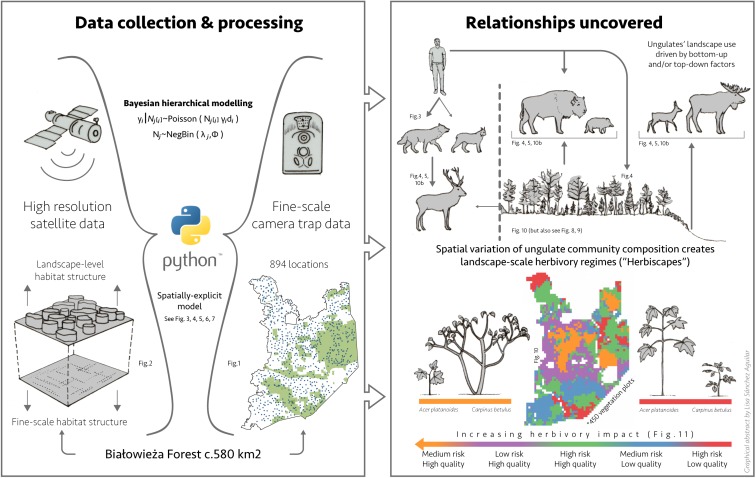
Graphical abstract presenting the steps taken to reveal the relationships uncovered in this study.